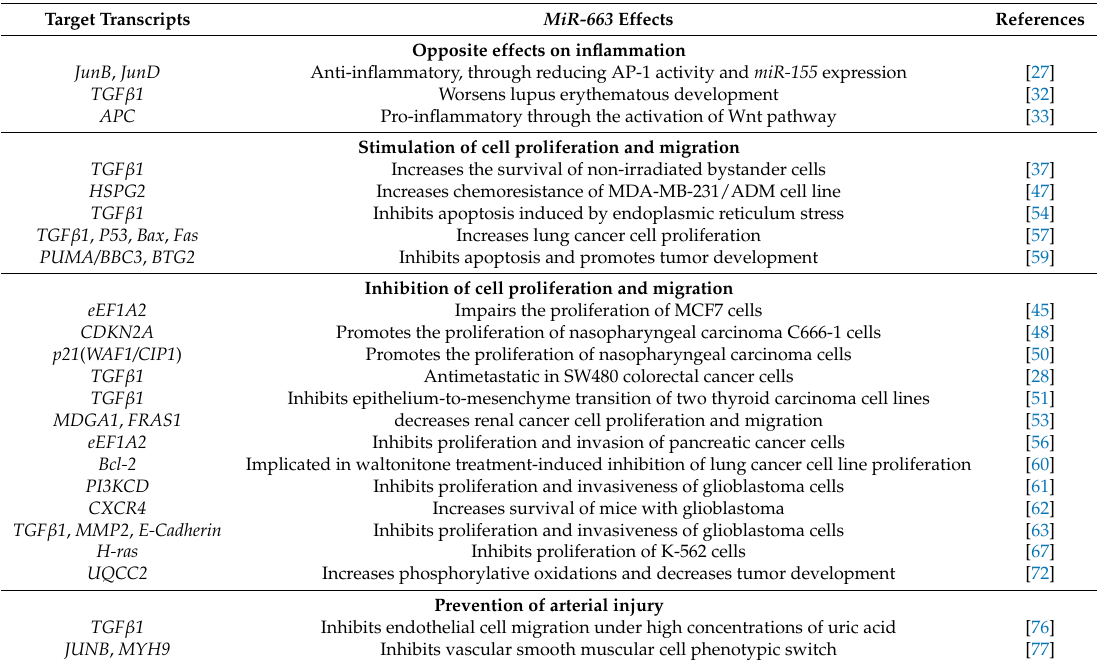
Table 1. Validated and putative target transcripts of miR-663 that link this microRNA with inflammatory, neurodegenerative and cardiovascular diseases, as well as with cancer. Target